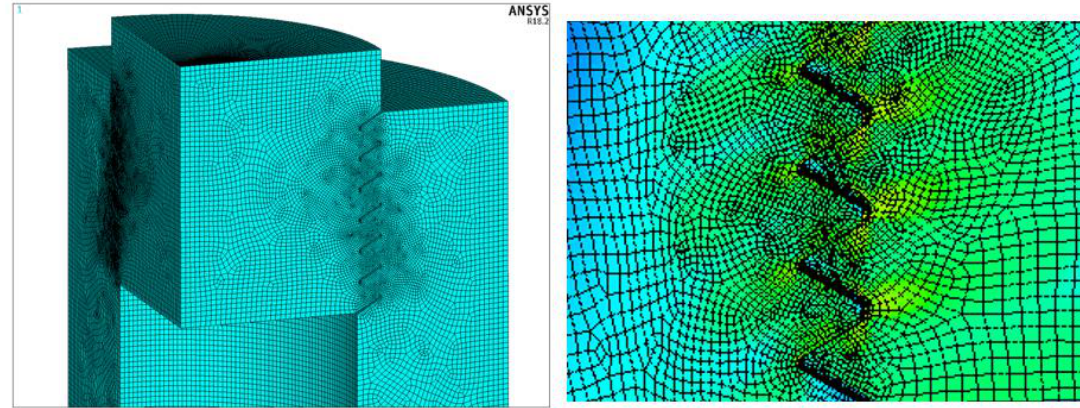
Figure 7. Finite element mesh at the internal M80 thread location of guide bar.